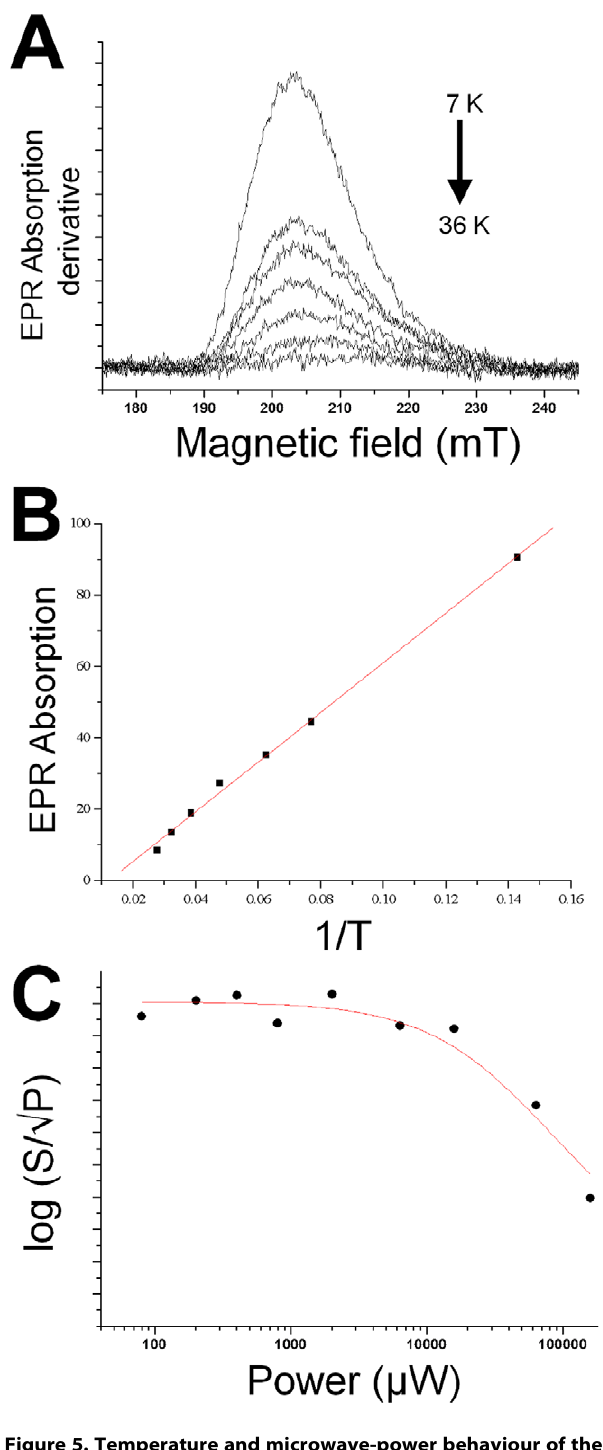
Figure 5. Temperature and microwave-power behaviour of the EPR signal of cytochrome c -554 from Methylosinustrichosporium OB3b. A. Temperature dependence of the HALS EPR spectrum. The spectra were recorded at 800 m W and the temperatures were 7, 13, 16, 21, 26, 31 and 36 respectively. B. The double integral of g-max plotted against the inverse temperature (1/T). Theline representsthelinear fit according to the Curie-law. C. Power saturation of the EPR spectrum. S equals the double integral of g-max, and P is the microwave power. The line is a simulated power saturation behaviour assuming a b-value of 1, indicating a P K value of 44 mW. The spectra were recorded in perpendicular mode with modulation amplitude 1 mT, modulation frequency 100 kHz, sweep time 168 s, time constant 82 ms and 4 6 10 4